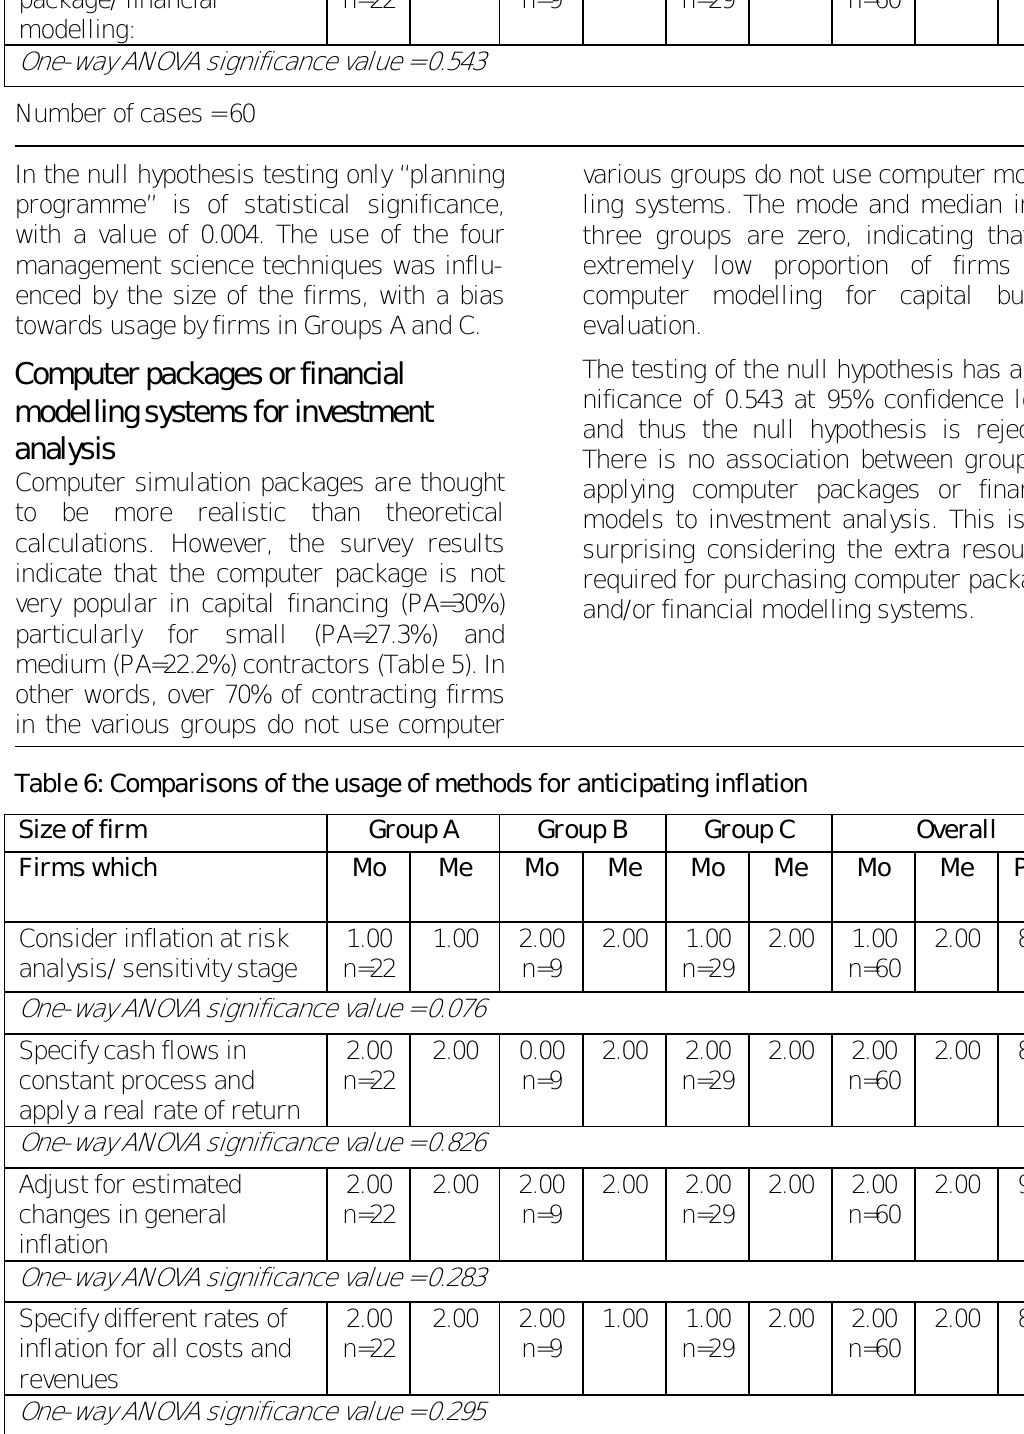
Firms use of computer package/ financial modelling: